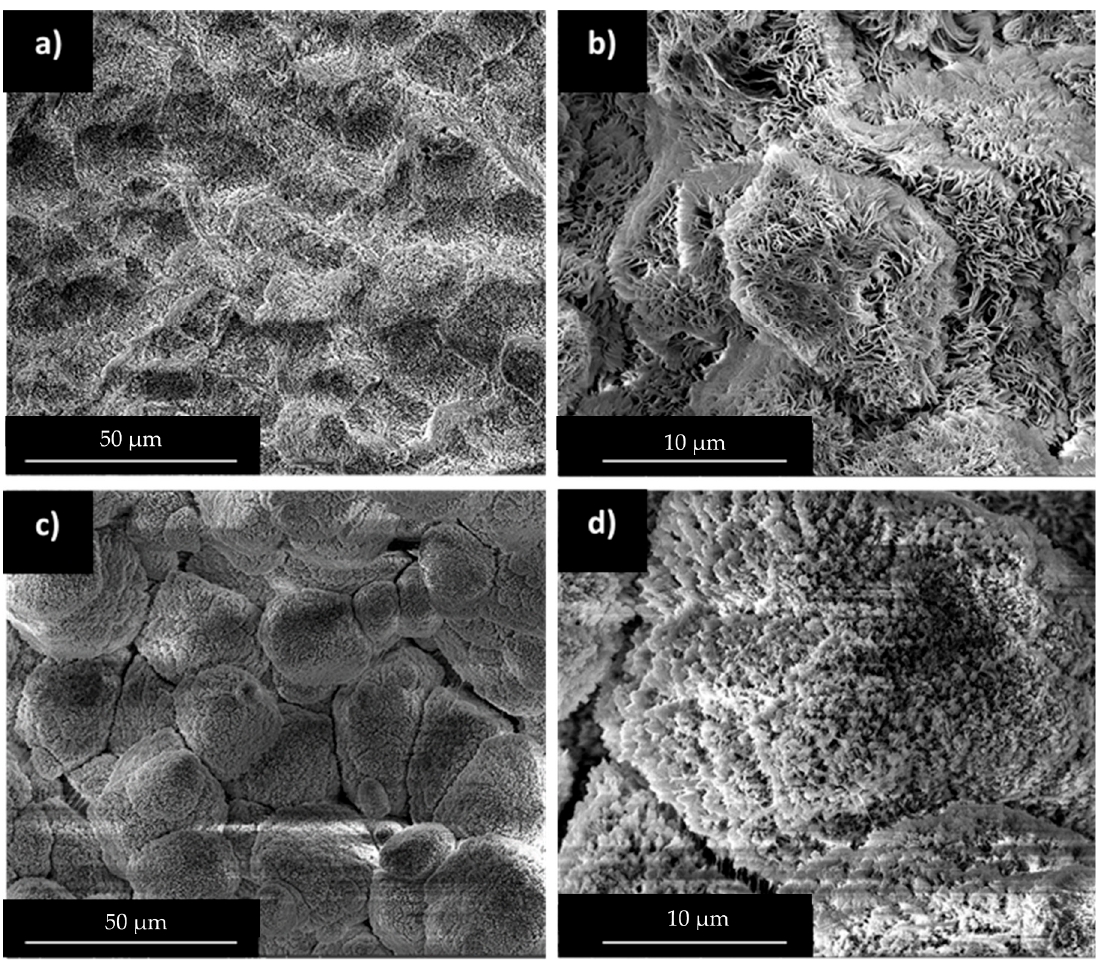
Figure 6. SEM observations after waxes (56 wt%) solvent extraction: ( a ) and ( b ) HDPE / wax, and ( c ) and ( d ) PP / wax.